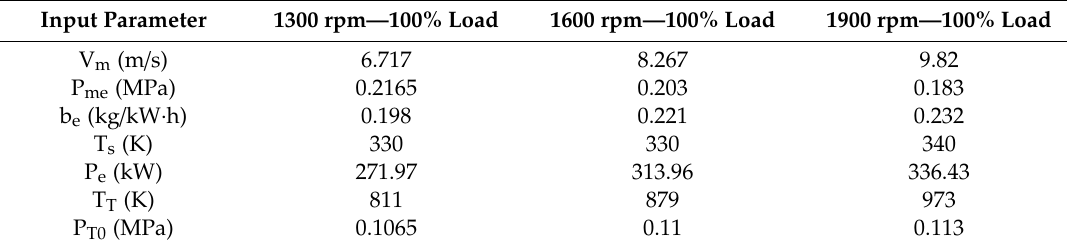
Table 2. Boundary